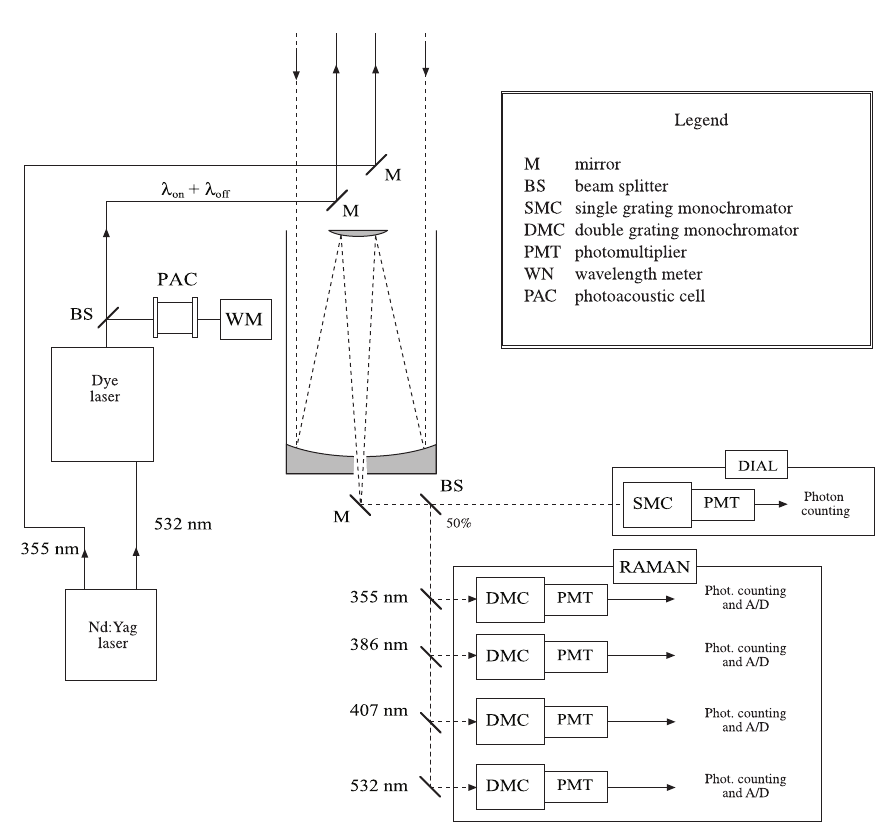
Fig. 1. Block diagram of the aerosol/water vapour lidar